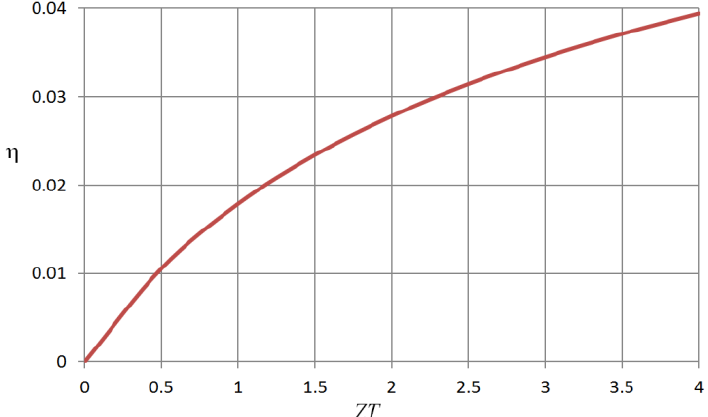
Figure 5. Plot of efficiency against dimensionless figure of merit for the heat source at 400 K and the heat sink at 360